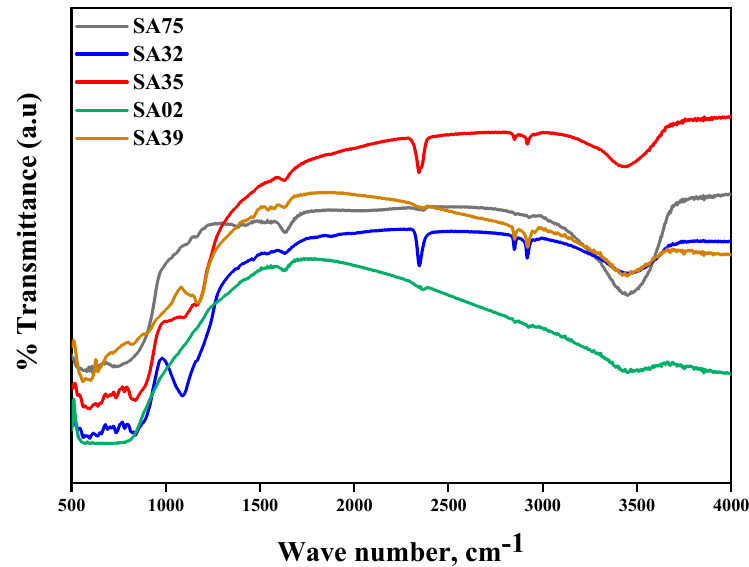
Figure 4. Evolution of the IR spectra of the Ni-supported samples.